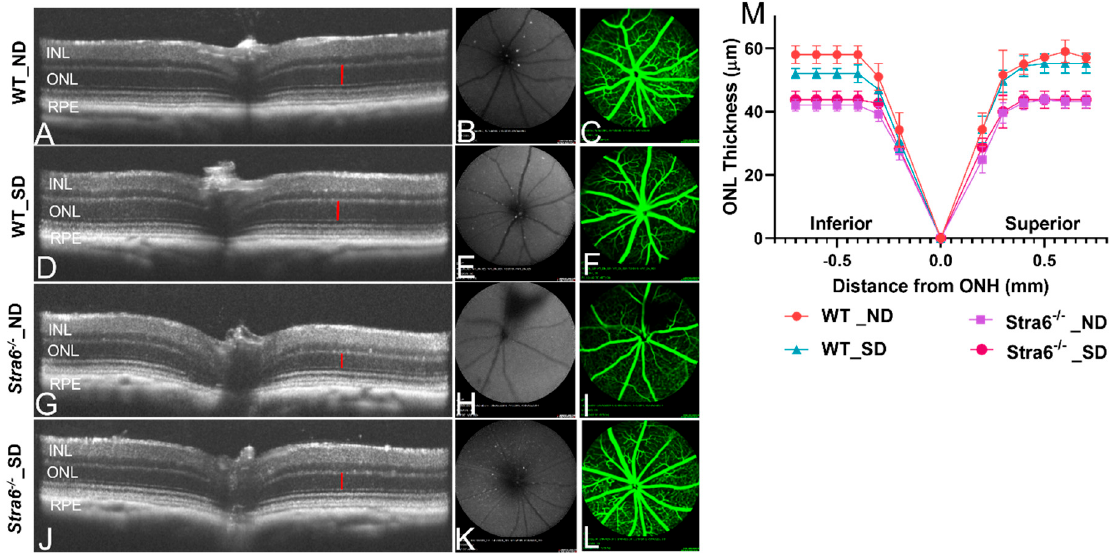
Figure 8. Imaging analysis of the retinal morphology of long-term diabetic mice . ( A – L ) Representative OCT images (left), fundus photography (middle), and fluorescence SLO (right panel) of long-term (30 weeks) non-diabetic and diabetic WT and Stra6 -/- mice. ( A ) Representative OCT mage for non-diabetic WT mice. ( B , C ) Fundus and fluorescence images for non-diabetic WT mice. ( D ) Representative OCT mage for diabetic WT mice. ( E , F ) Fundus and fluorescence images for diabetic WT mice. ( G ) Representative OCT mage for non-diabetic Stra6 -/- mice. ( H , I ) Fundus and fluorescence images for non-diabetic Stra6 -/- mice. ( J ) Representative OCT mage for diabetic Stra6 -/- mice. ( H , I ) Fundus and fluorescence images for diabetic Stra6 -/- mice. ( M ) The outer nuclear layer thickness was measured from each genotype and condition ( n = 4) and blotted in the graph. INL, inner nuclear layer; ONL, outer nuclear layer; and RPE, retina pigment epithelium.